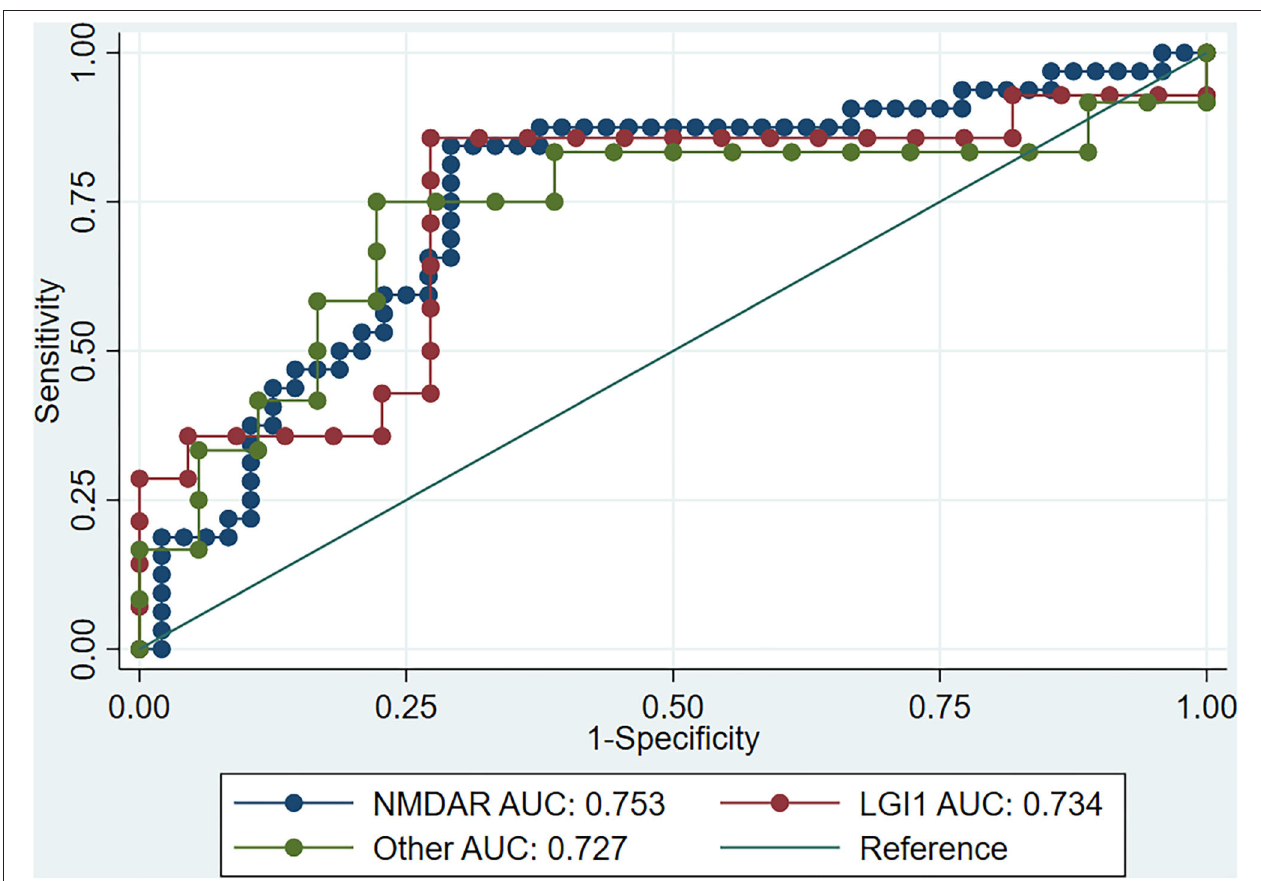
FIGURE 2 | ROC curve of SII for immunotherapy response in different AE types. ROC, receiver operating characteristic; SII, systemic inflammation index; AE, autoimmune encephalitis; NMDAR, N-methyl-D-aspartate receptor; LGI1, leucine-rich glioma-inactivated 1.